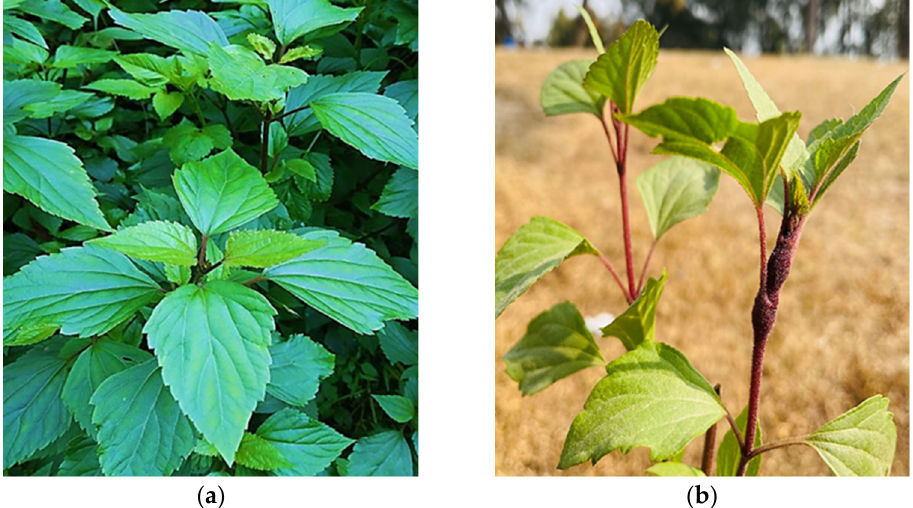
Figure 1. ( a ) The morphological structure of the Ageratina adenophora plant and ( b ) Small nodules developed on the plant’s stem.